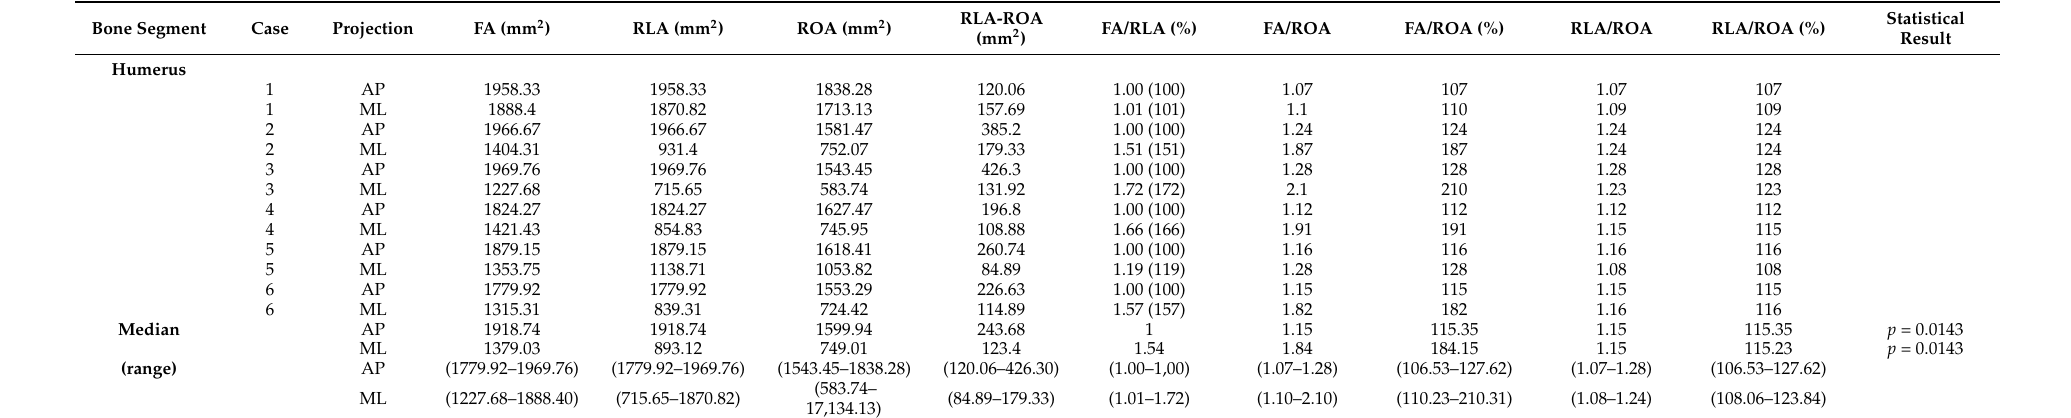
Table 1. Measurements of the Humerus in the antero-posterior (AP) and medio-lateral (ML)